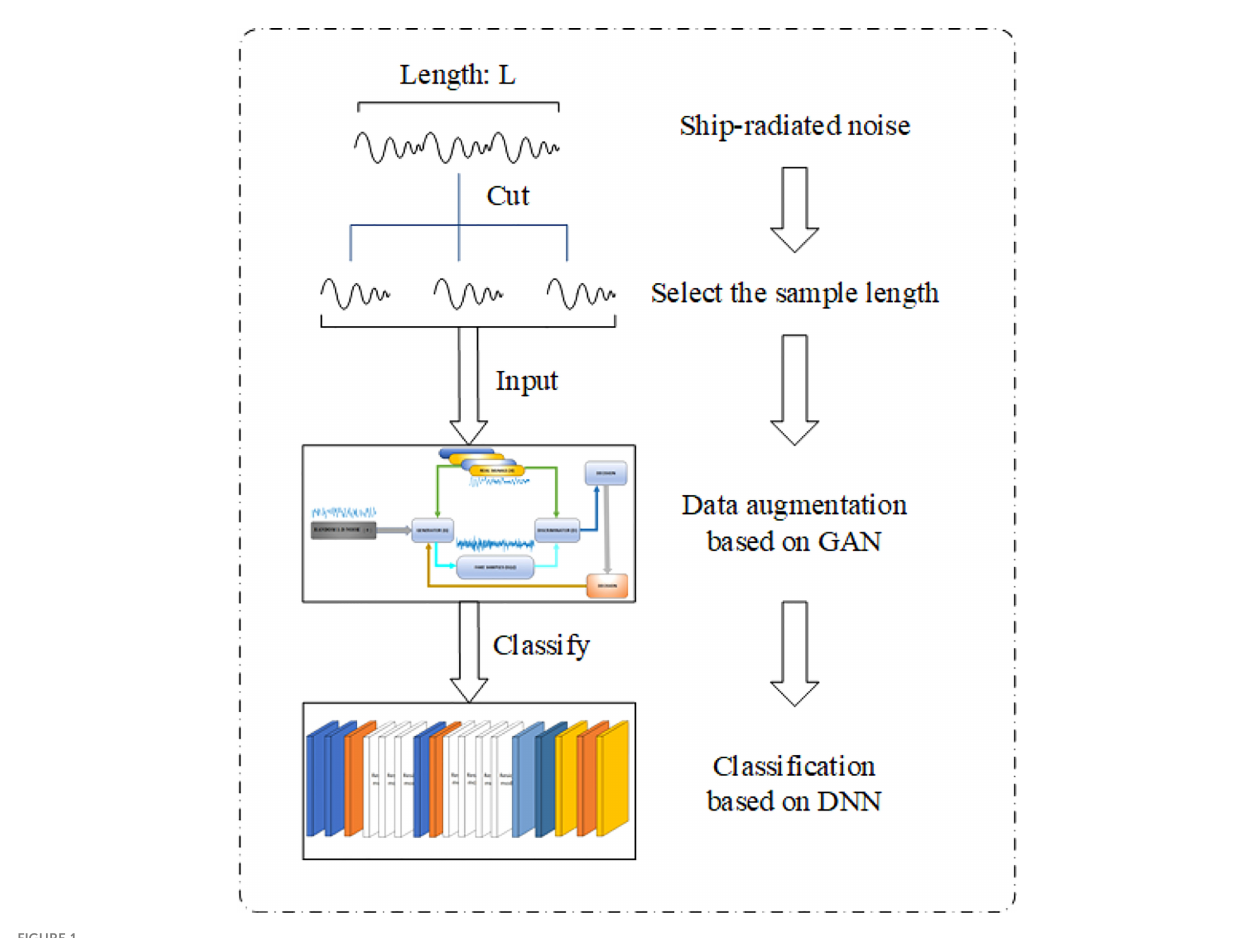
FIGURE 1 General algorithm framework.